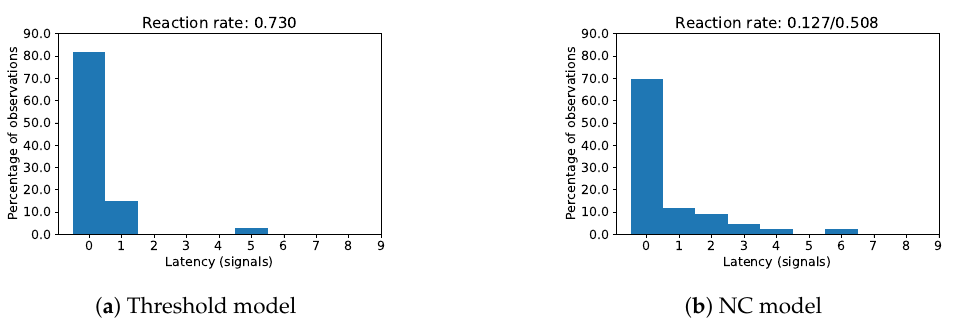
Figure 13. Reaction rates (cf. Assumption 4a) and histograms of reaction latencies (cf. Assumption 4b) for online label feedback: Reaction latencies are small for both anomaly detection models. The reaction rate is smaller for the NC model ( b ) than for the threshold model ( a ).